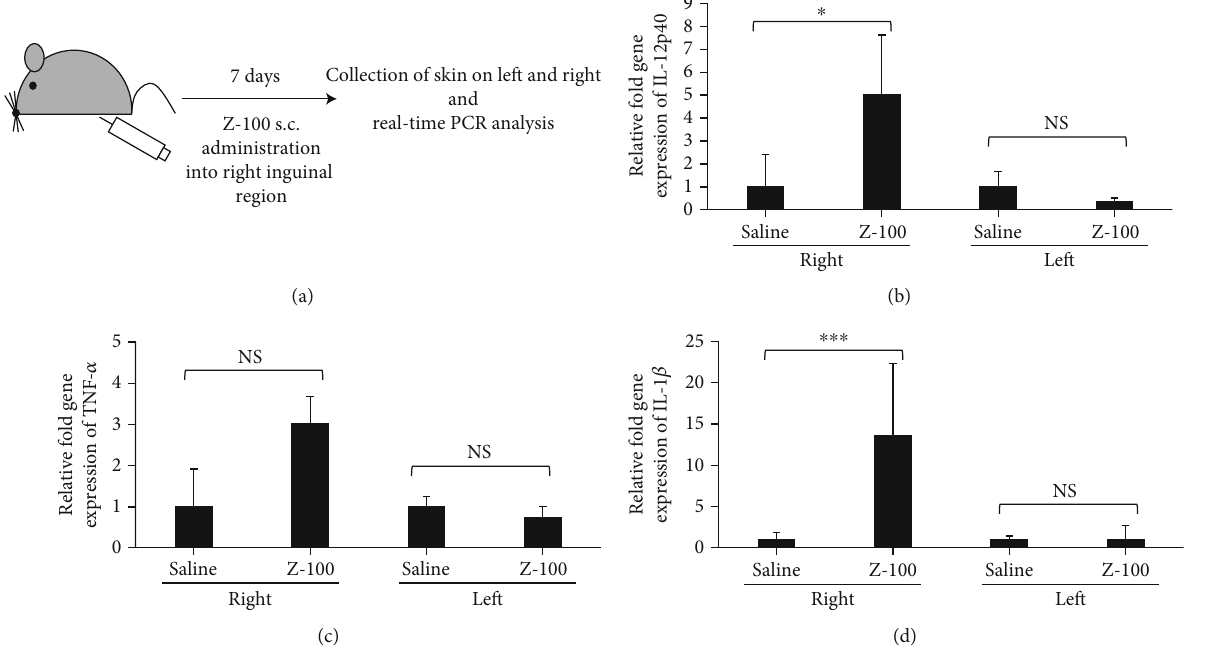
Figure 6: Z-100-mediated increase in cytokine expression in vivo . (a) Schematic of the experimental design. After administering Z-100 into the right inguinal region for 7 days, skin samples were collected from the left inguinal region and right inguinal region. (b – d) Relative fold gene expression of IL-12p40 (b), TNF- α (c), or IL-1 β (d) in skin samples from the left and right. Data show the mean ± range ; n = 4 -6 per group. The ranges were determined by evaluating the expression: 2 - ΔΔ CT with ΔΔ CT + S : E : and ΔΔ CT – S.E., where S.E. is the standard error of the mean of the ΔΔ CT value. TNF- α in skin samples from the right and IL-1 β in skin samples from the left were analyzed using Aspin- Welch ’ s t -test; all other analyses were performed using Student ’ s t -test ( ∗ P < 0 : 05 , ∗∗∗ P < 0 : 001 , and NS: not signi fi cant vs.